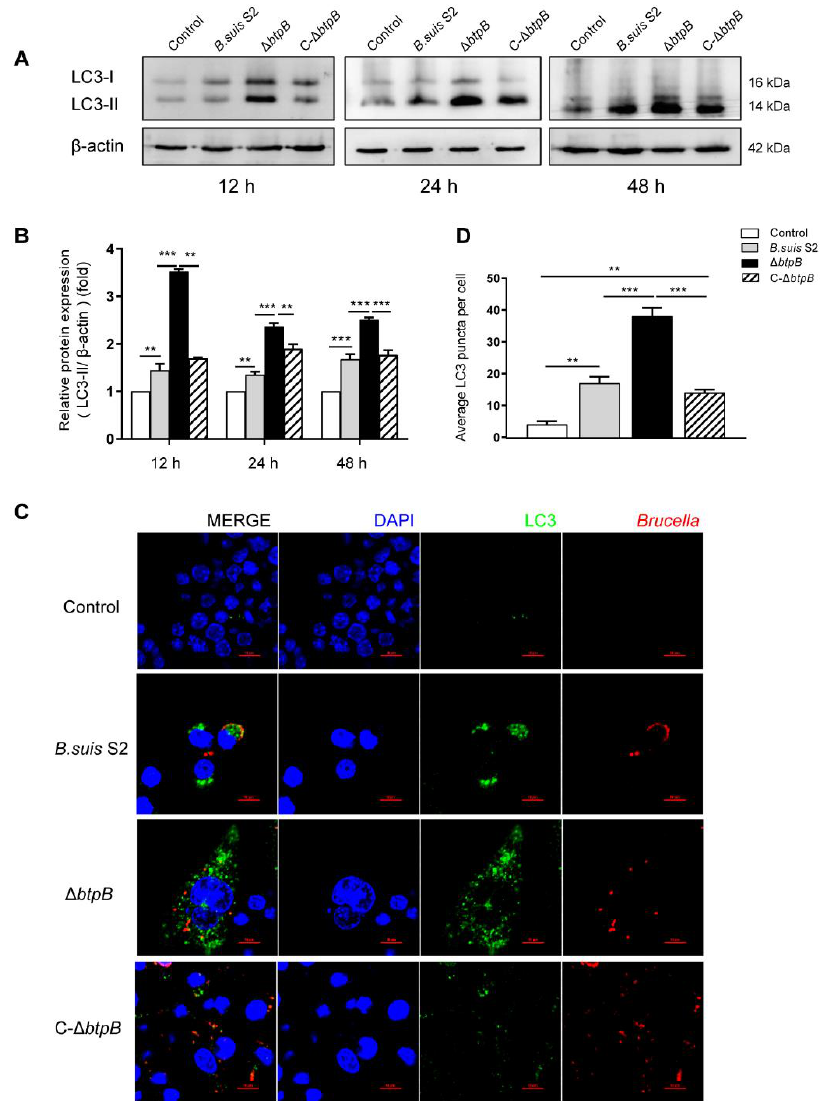
Figure 2. ∆ btpB promotes the expression of LC3-II protein and LC3 puncta. ( A ) RAW264.7 cells were infected with Brucella strains (MOI = 200) for 12, 24, and 48 h. At the indicated time point, the LC3 and β -actin expression levels were detected by immunoblotting analysis with specific